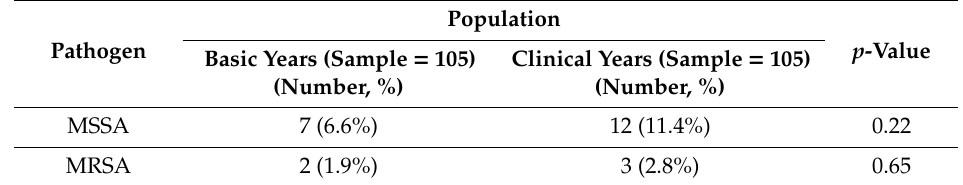
Table 1. number and percentage of MSSA and MRSA among basic and clinical years medical students.